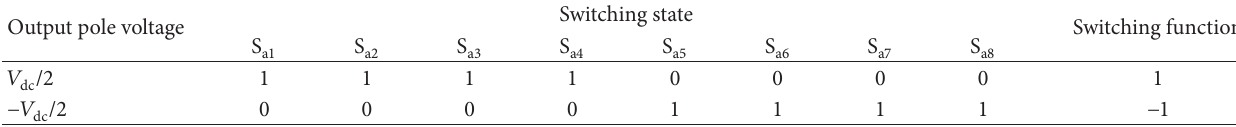
Table 4: Switching states of two-level